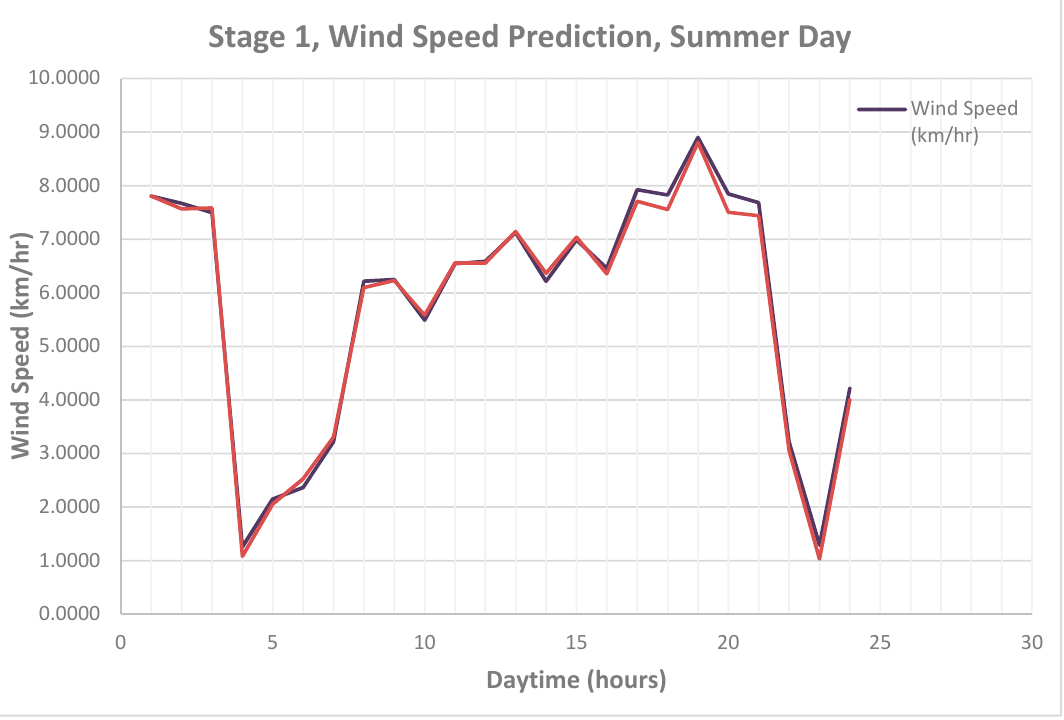
Figure 11. Wind Speed forecasting results from Stage 1, Summer Day.